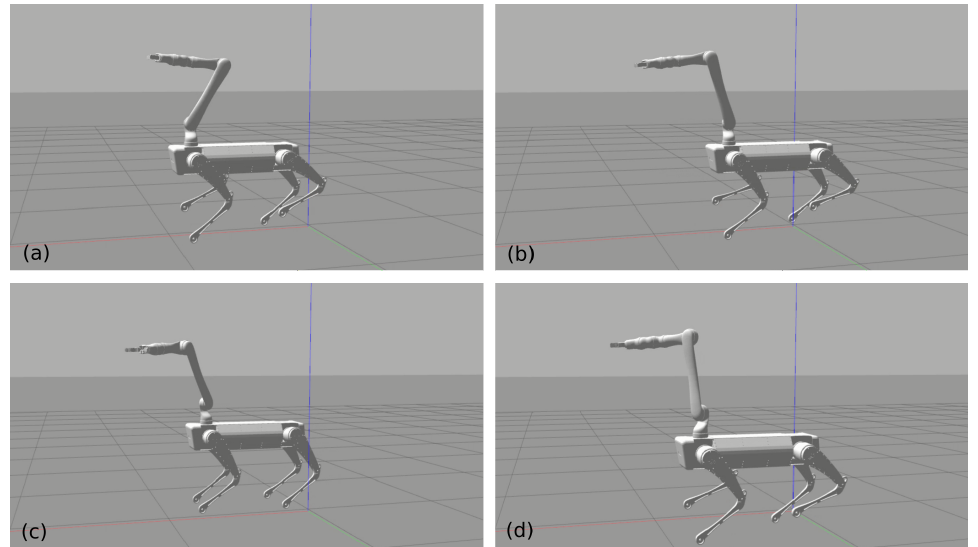
Figure 5. Snapshots of the “chicken head” motion. The end-effector is controlled to stay at a fixed position while the quadruped robot is trotting around. ( a ) The initial position. ( b ) Walking to the left side. ( c ) Walking back. ( d ) Walking to the right side.